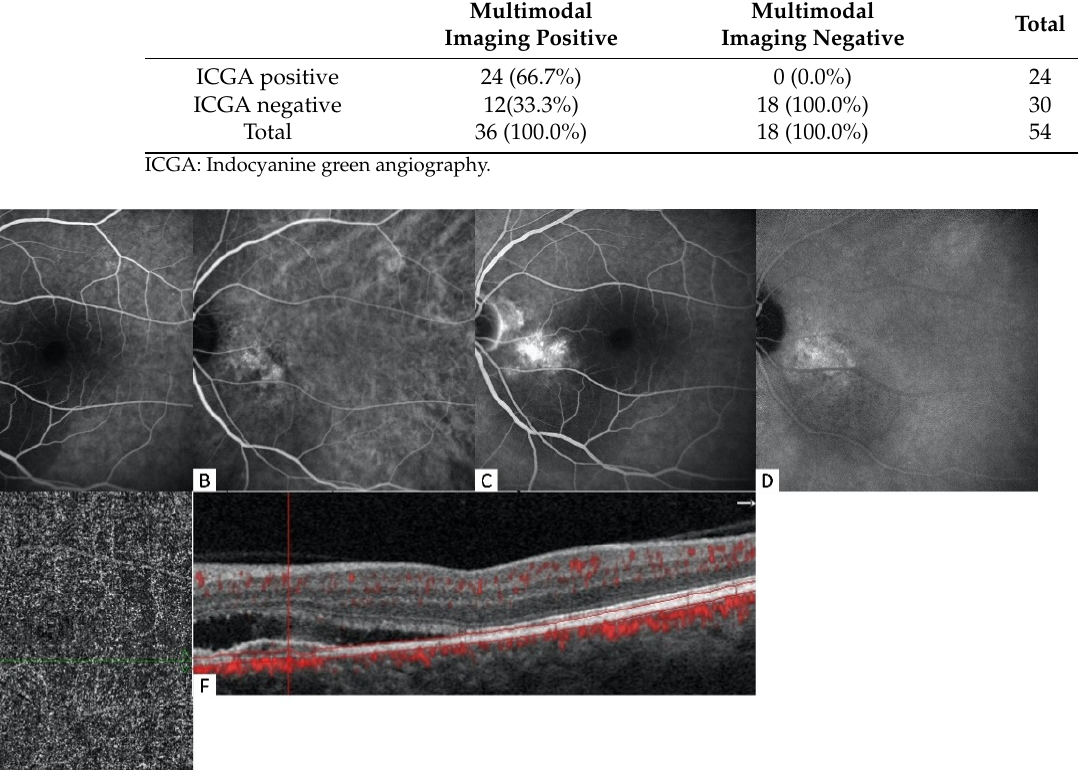
OCTA: optical coherence tomography angiography. Table 2. Comparison of the multimodal imaging techniques and ICGA for the diagnostic accuracy of macular neovascularization. Multimodal Imaging Positive